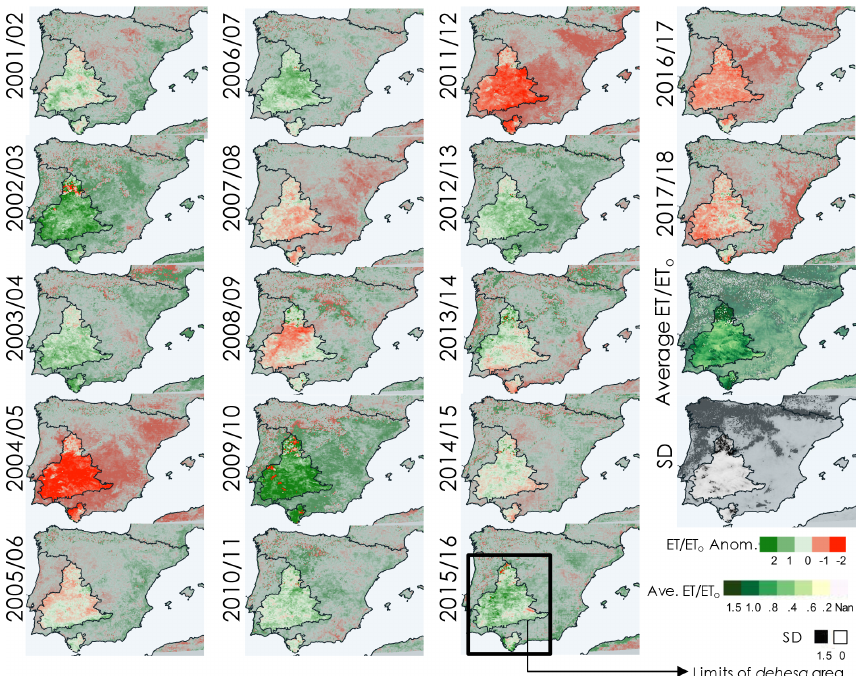
Figure 6. Spatial distribution of annual anomalies of relative evapotranspiration for the oak savanna area of the Iberian Peninsula from 2001/2002 to 2017/2018, the average ET / ET o for the period and its standard deviation